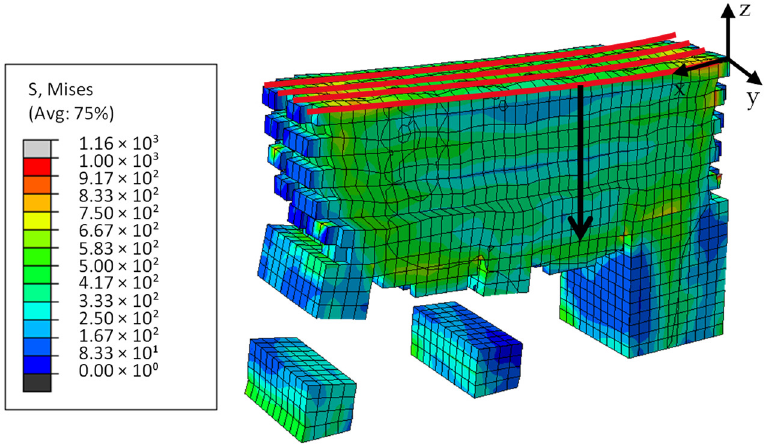
Figure 7. Model cut: cantilever after partial separation—path for distortion evaluation marked in red and path for stress evaluation marked in black.